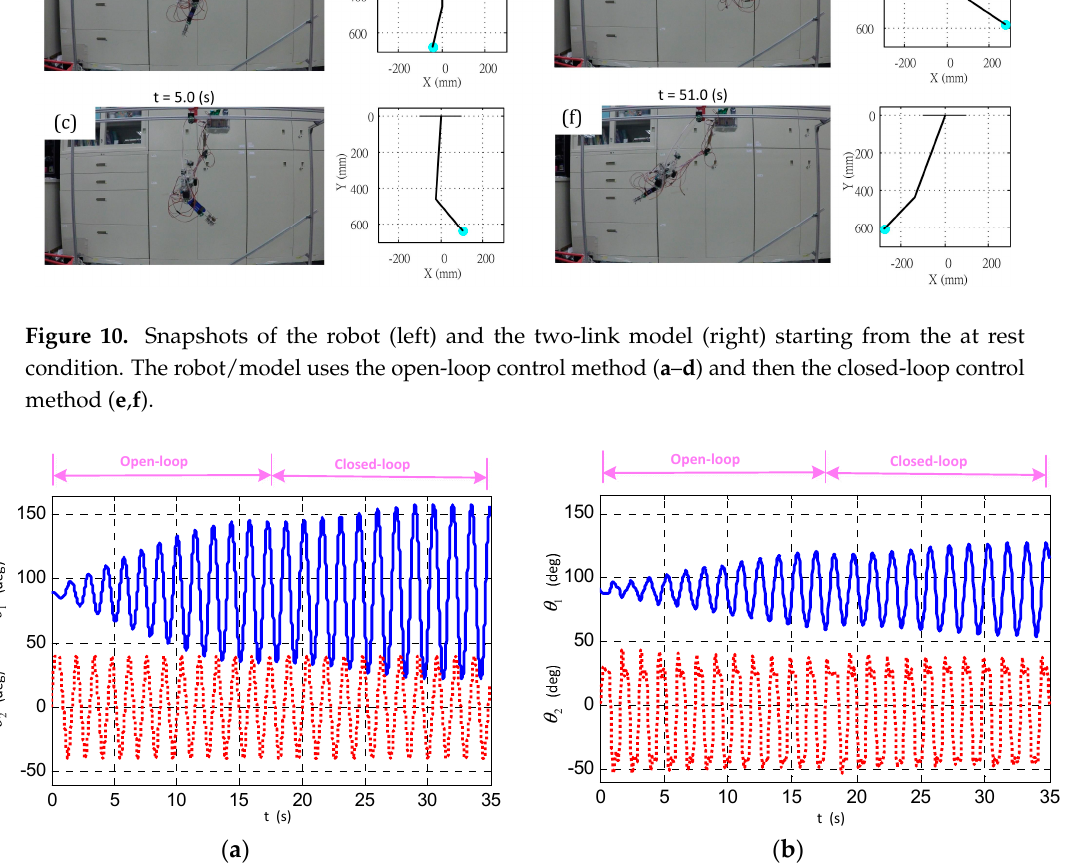
Figure 11. A simulation of the ( a ) two-link model and the experimental result of the ( b ) MonkeyBot with the hybrid control strategy.